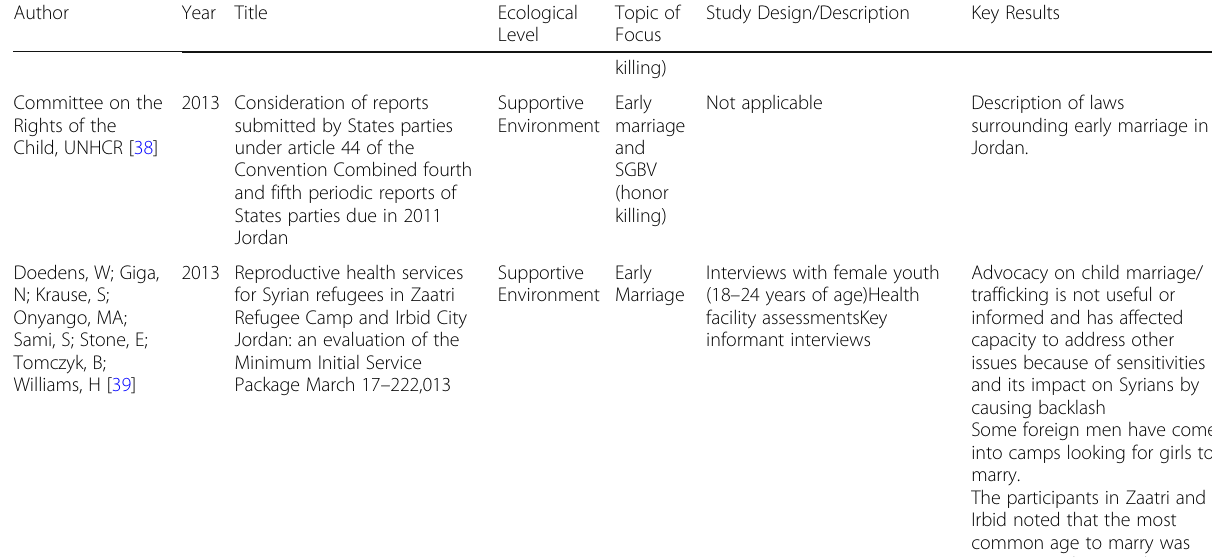
Table 1 Summary of the 27 documents included in the analysis according to ecological level and topic of focus pertinent to sexual- and gender-based violence and early marriage among youth in Jordan